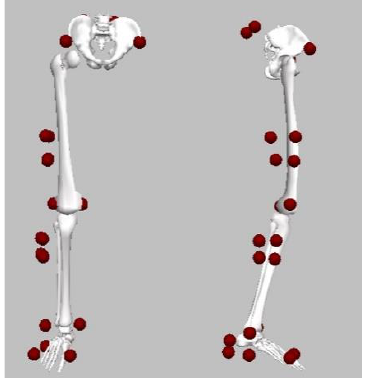
Figure 2. Illustration of the marker set.